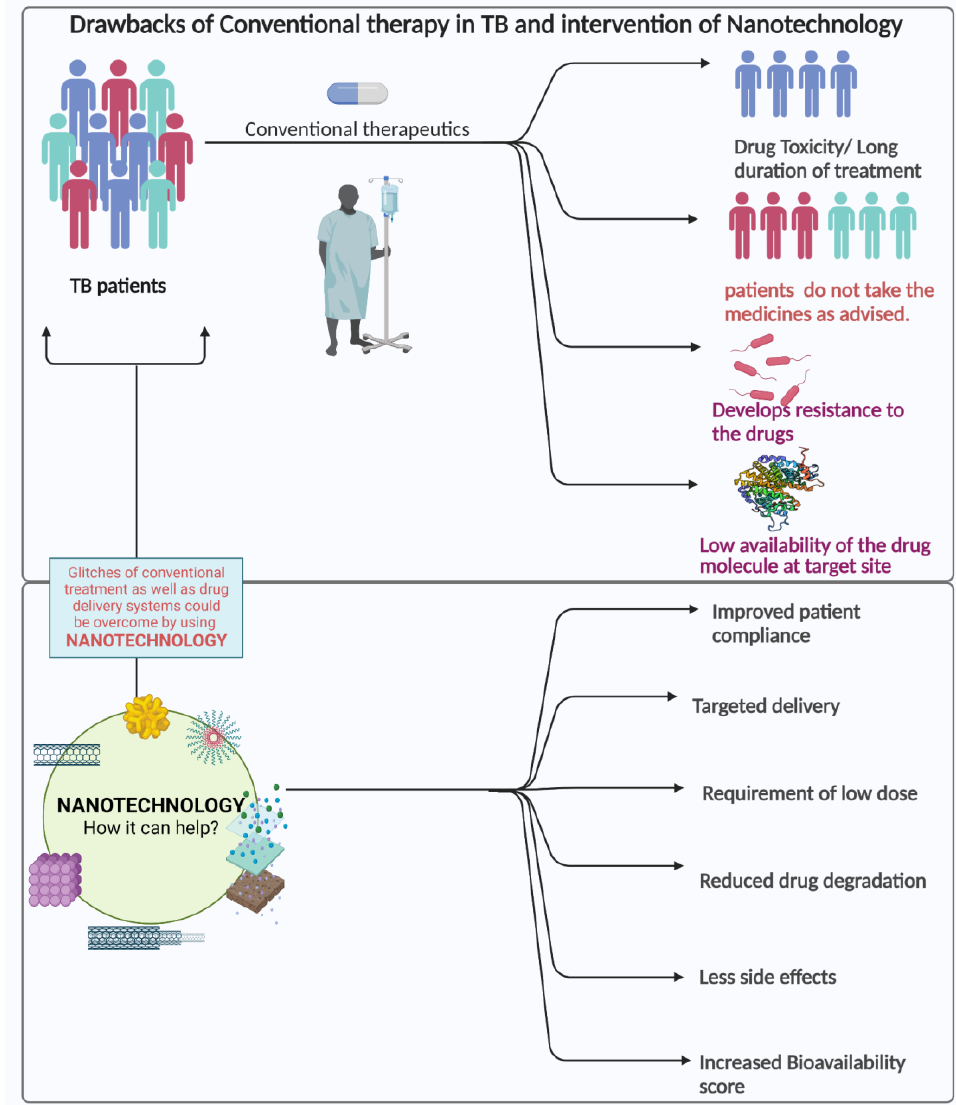
Figure 3. Comparison of traditional vs. nanosystems for the treatment of TB (Created with BioRender.com).